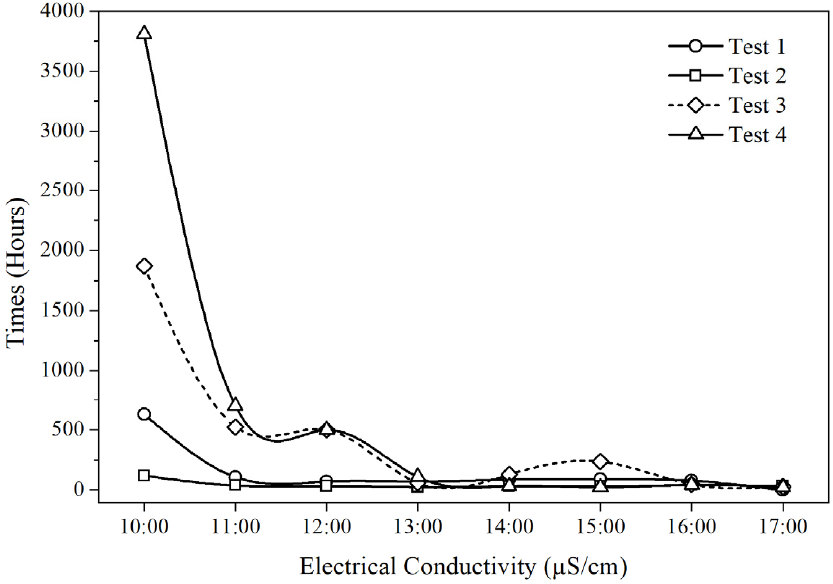
Figure 8. Electrical conductivity of the water obtained with the solar still.